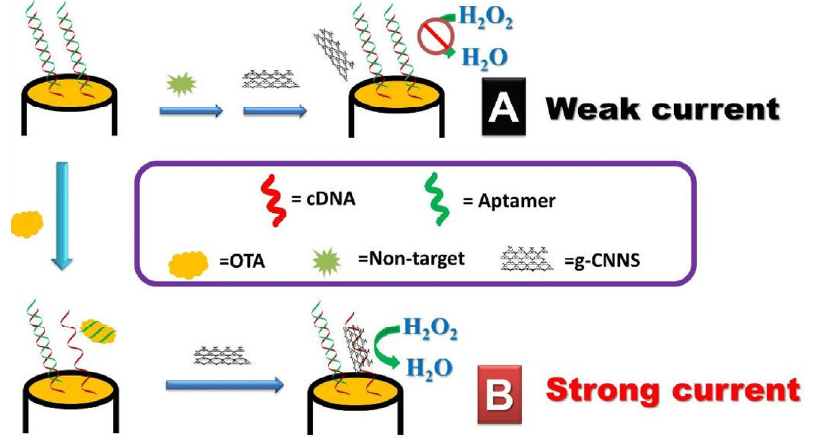
Figure 24. Aptasensor for OTA exploiting graphitic carbon nitride nanosheets as electrocatalytic labels. Adapted with permission from Zhu et al. [138] (copyright © (2018), Elsevier).